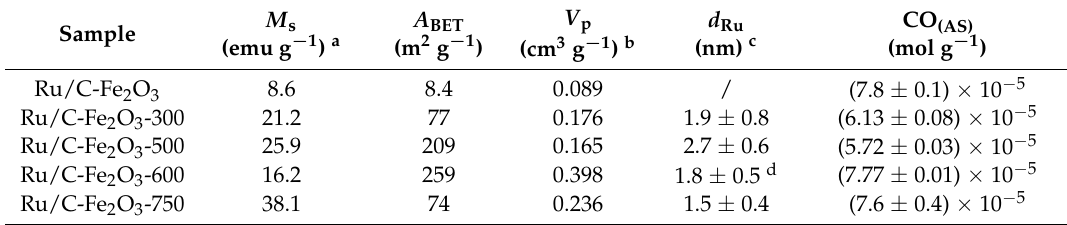
Table 1. Effect of the annealing temperature on properties of catalysts.